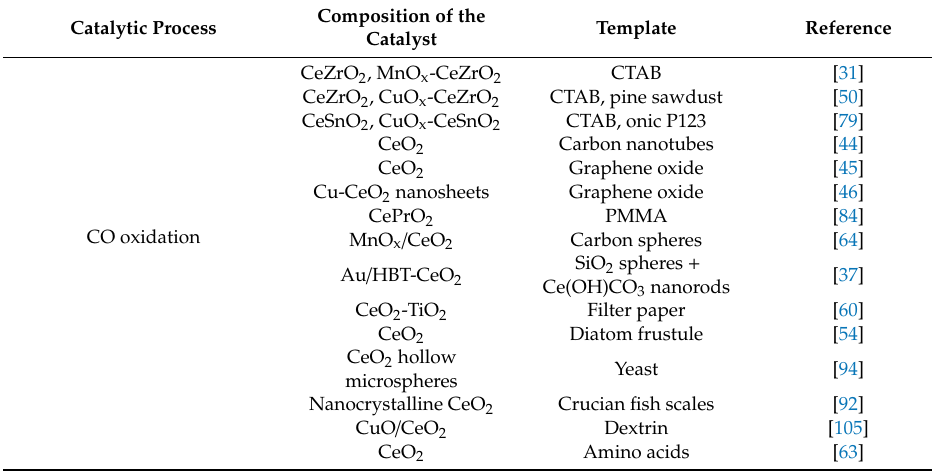
Table 1. Catalytic applications of ceria-based materials produced using template methods. tion of abbreviations can be found in the text of the